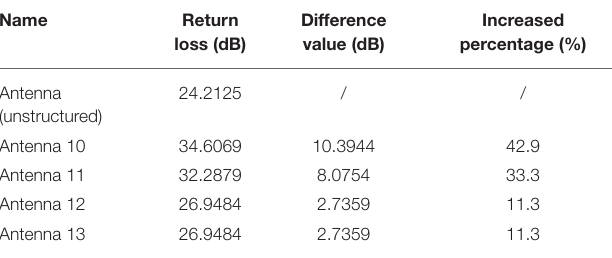
TABLE 1 | Comparison of perforated antennas with the unstructured antennas.